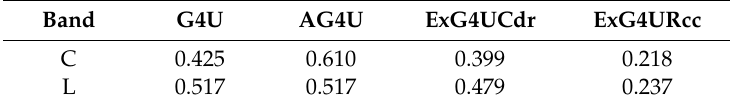
Table 3. Normalized volume scattering power statistics for oriented urban areas.